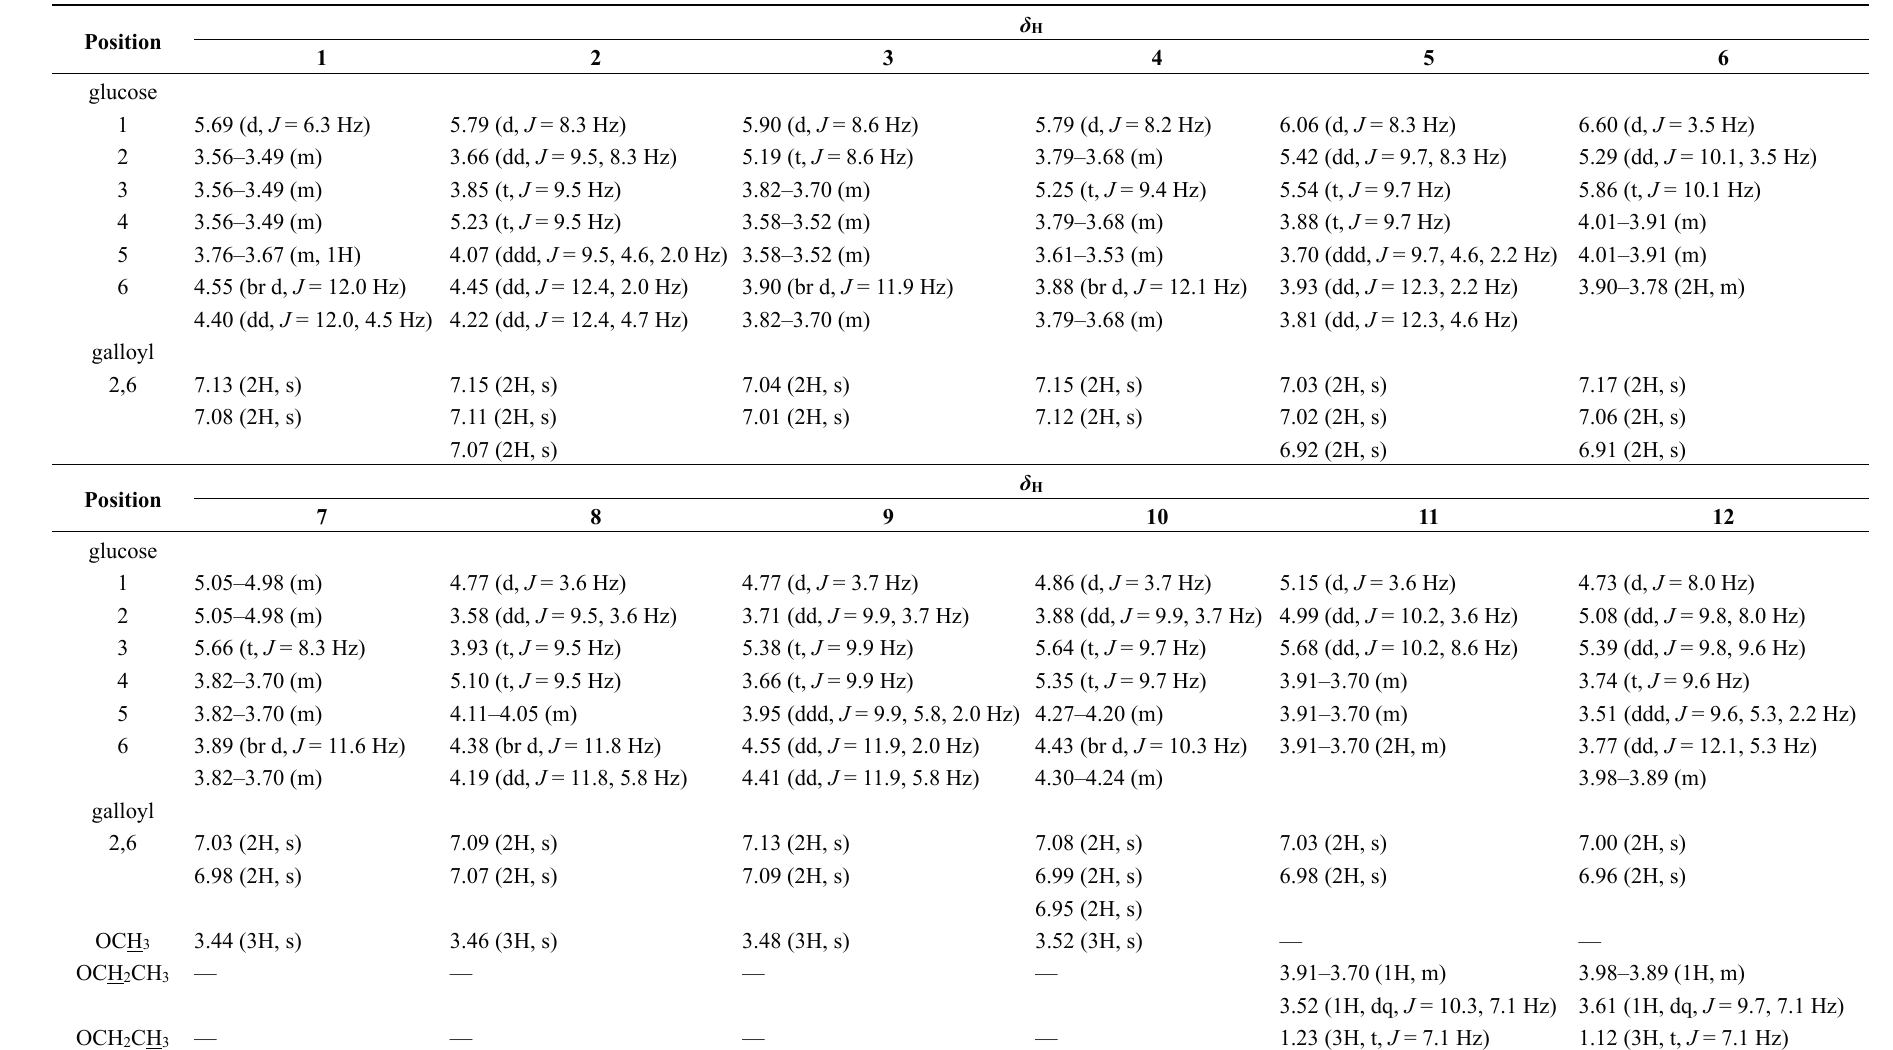
Table 4. 400 MHz 1 H-NMR data of 1 – 12 in CD 3 OD a